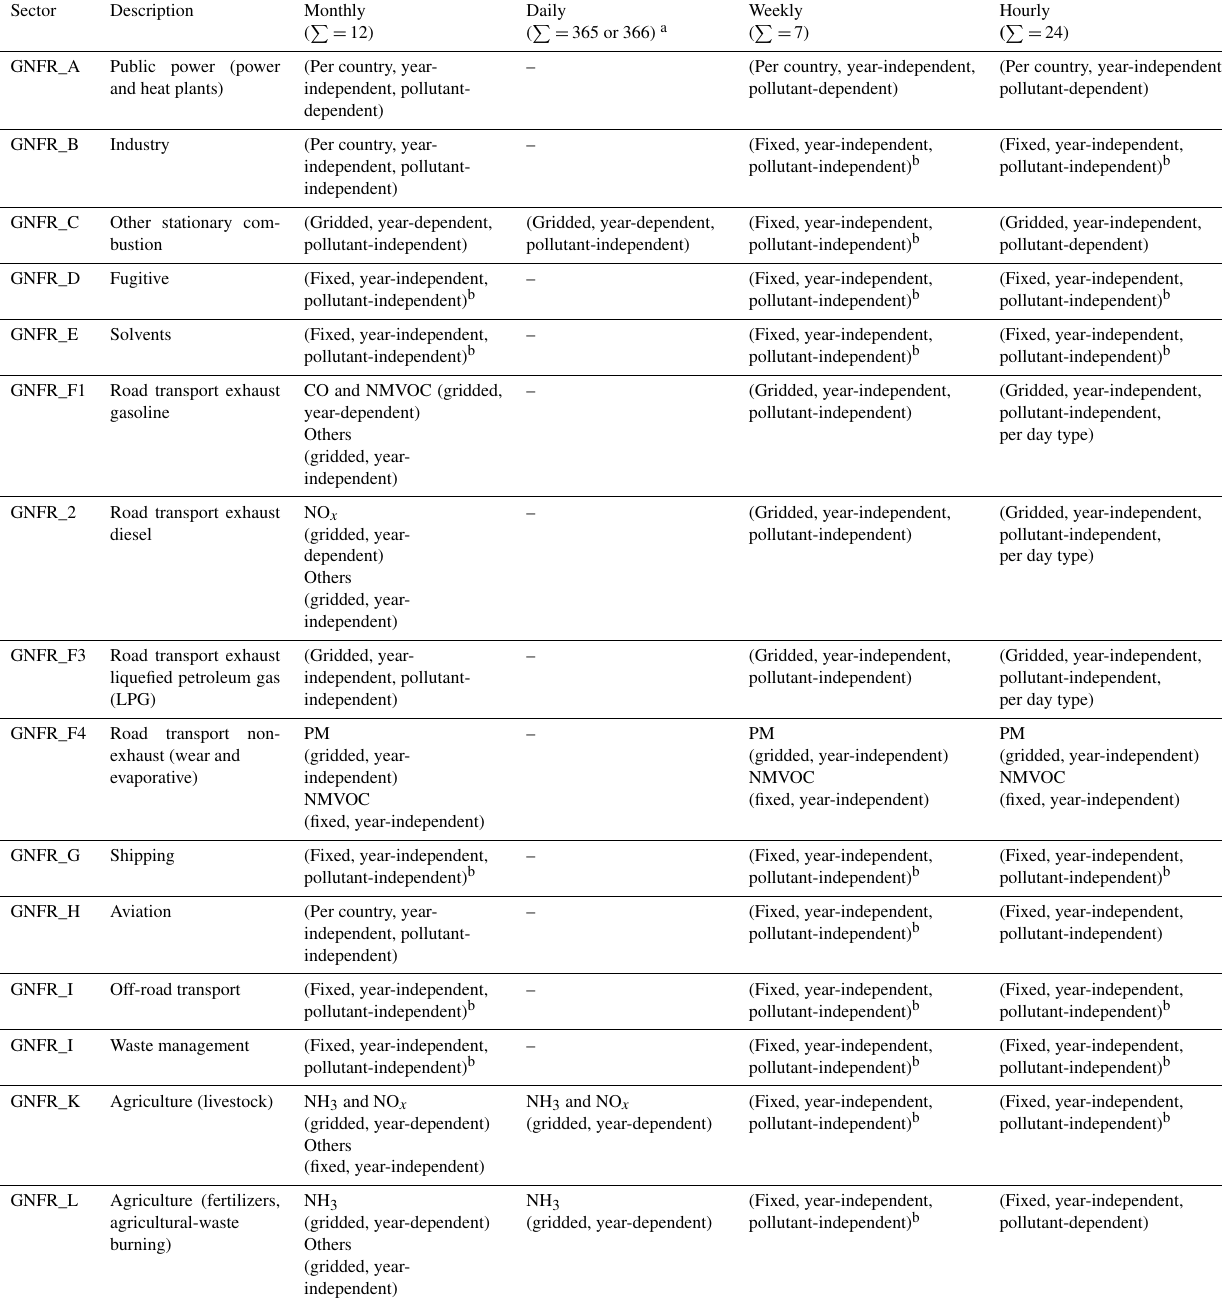
Table 3. Main characteristics of the CAMS regional temporal profiles (CAMS-REG-TEMPO) reported by sector and temporal resolution (monthly, daily, weekly and hourly). The text between brackets gives information on the spatial resolution and pollutant and year dependency of each profile. Gridded indicates that the profile varies per grid cell within a country; per country indicates that the profile varies only per country; fixed indicates that the profile is spatially invariant; year-independent indicates that the profiles does not vary per year; year- dependent indicates that the profile varies per year; pollutant-independent indicates that the same profile is proposed for all pollutants (NO x , SO x , NMVOC, NH 3 , CO, PM 10 , PM 2 . 5 , CO 2 and CH 4 ); pollutant-dependent indicates that the profile varies per pollutant; per day type indicates that the profile varies as a function of the day (weekday, Saturday and Sunday). The symbol “–” denotes that no profile is